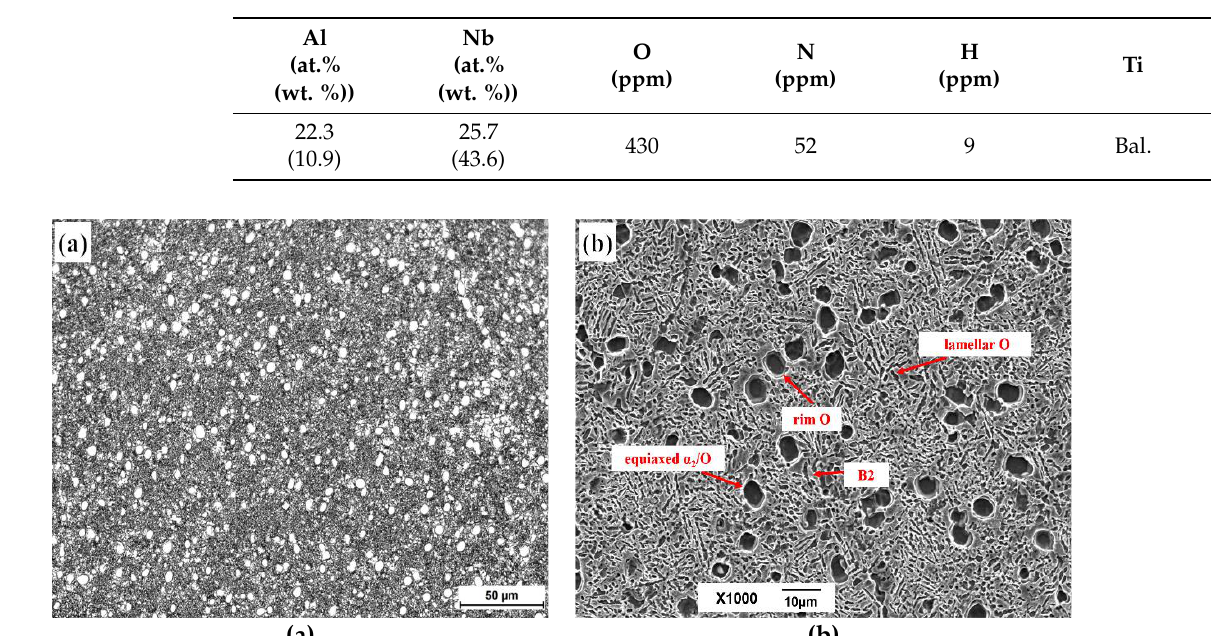
Table 1. Chemical composition of Ti-22Al-25Nb alloy.